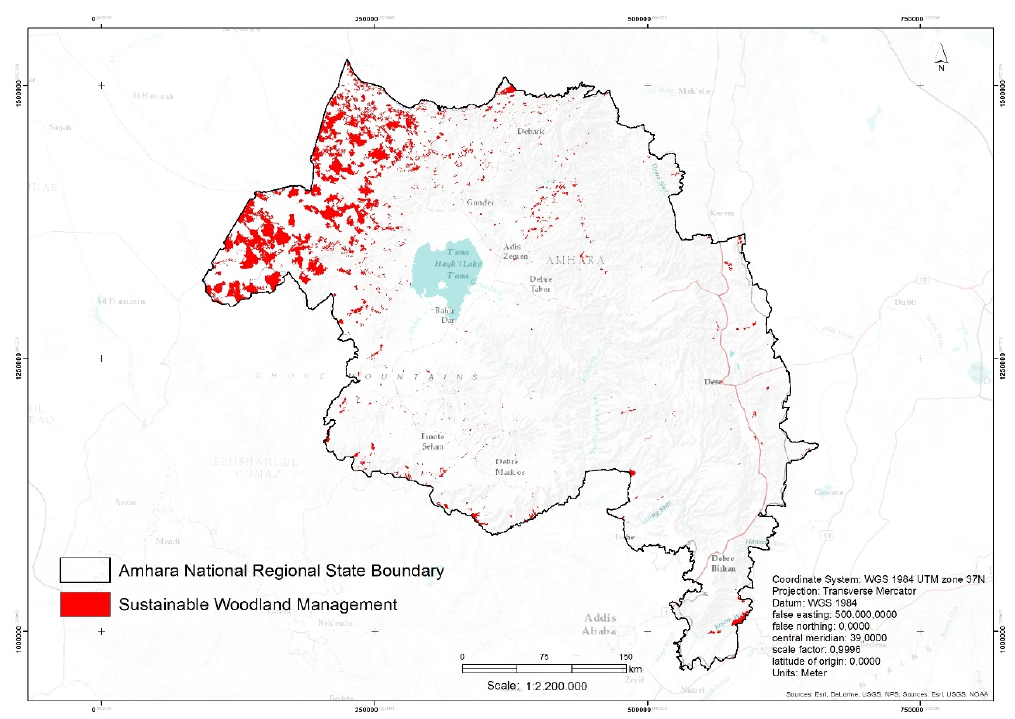
Figure 5. Opportunity areas for sustainable woodland management.